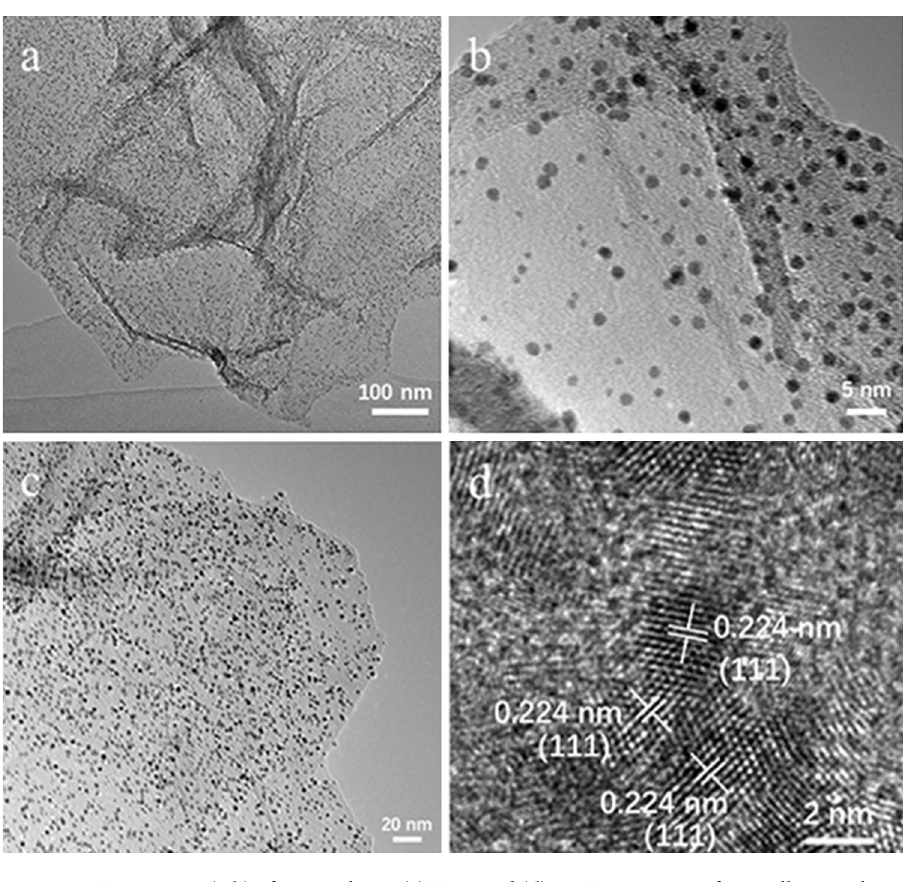
Figure 2. TEM image ( a , b ) of Ni-graphene. ( c ) TEM and ( d ) HRTEM images of PtNi alloy-graphene.